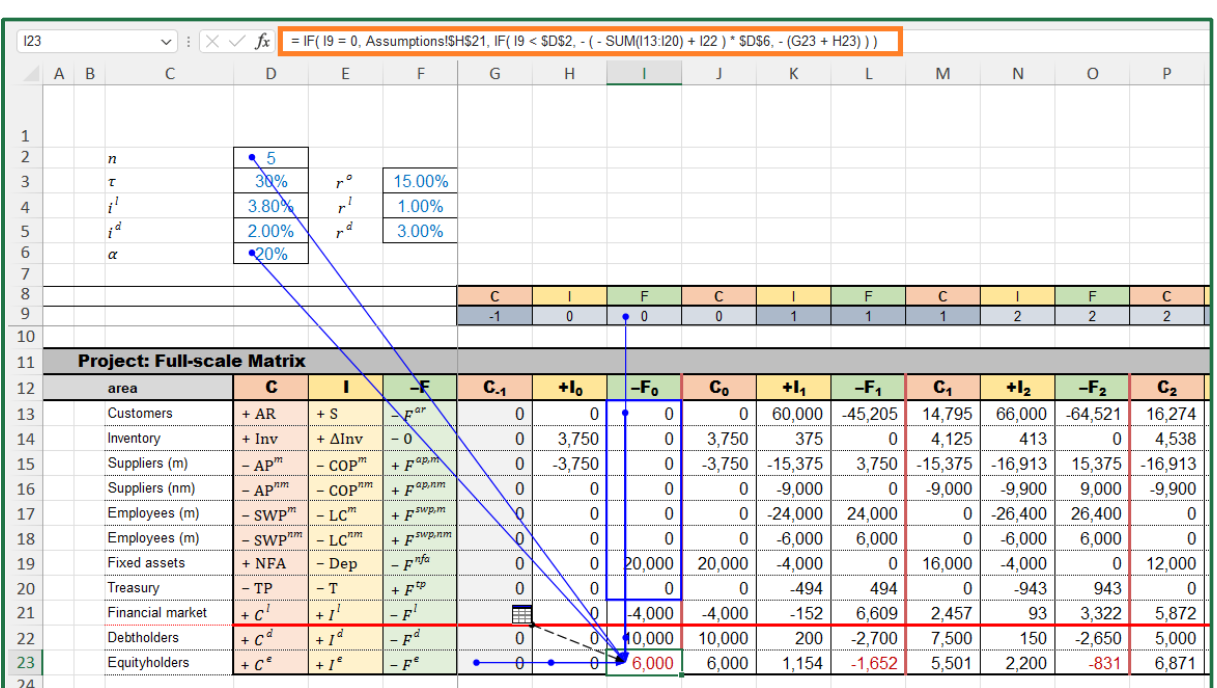
Figure A1. An alternative way to determine the Cash Flow to Equity in cell I23 (“SplitScreenStrip” sheet).